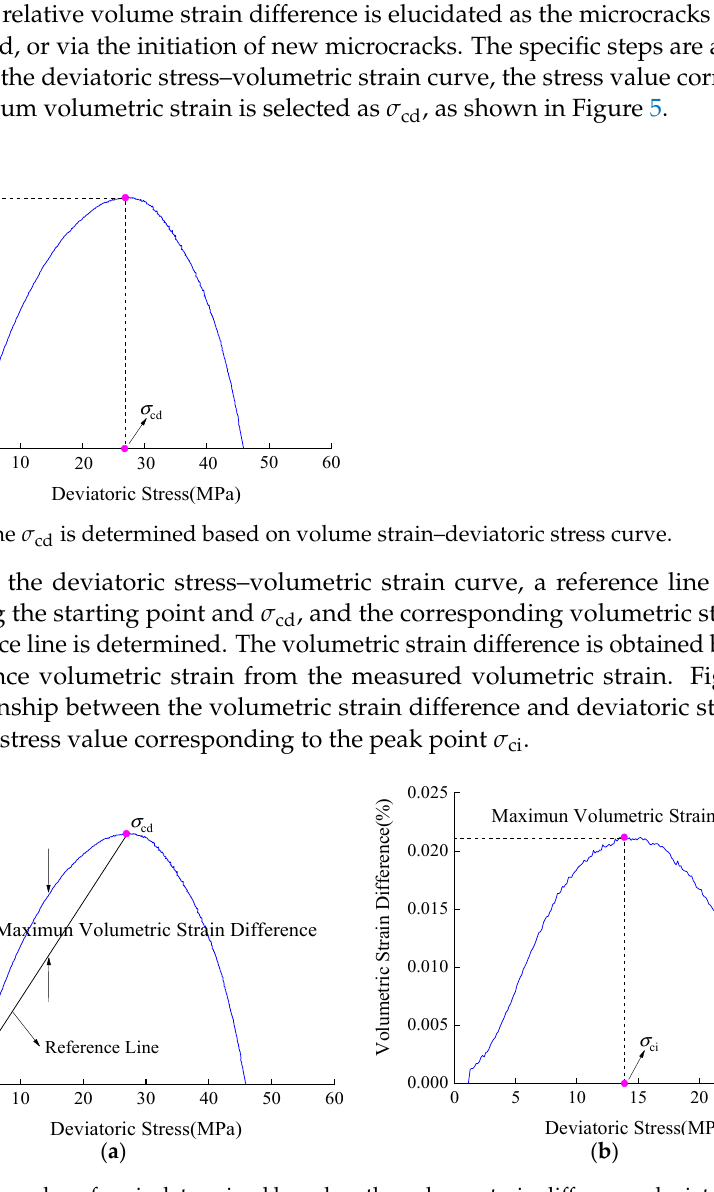
Figure 4. Different methods to determine the σ cc or σ ci values: ( a ) VS; ( b ) LS; ( c ) CVS; and ( d ) LSR.